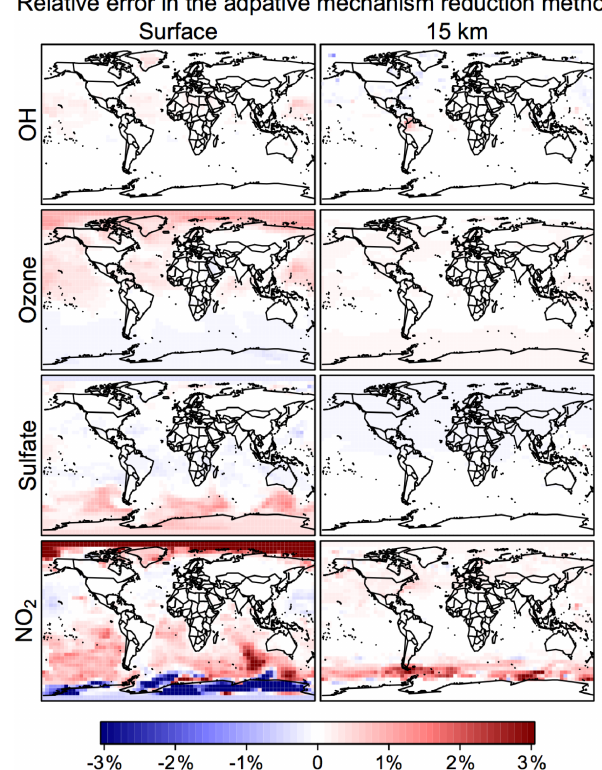
Figure 7. Relative error from the adaptive mechanism reduction method after 2 years of simulation in the GEOS-Chem global 3- D model for tropospheric-stratospheric chemistry. The figure shows relative differences of 24h average OH, ozone, sulfate, and NO 2 concentrations relative to the full-chemistry simulation on the last day of the 2-year simulation (2013–2014). The relative error for surface NO 2 can be up to ± 10% in polar regions. The calculation uses a rate threshold δ = 500moleculescm − 3 s − 1 to partition the species between fast and slow. The number of blocks ( N ) is 12 and the number of chemical regimes ( M ) is